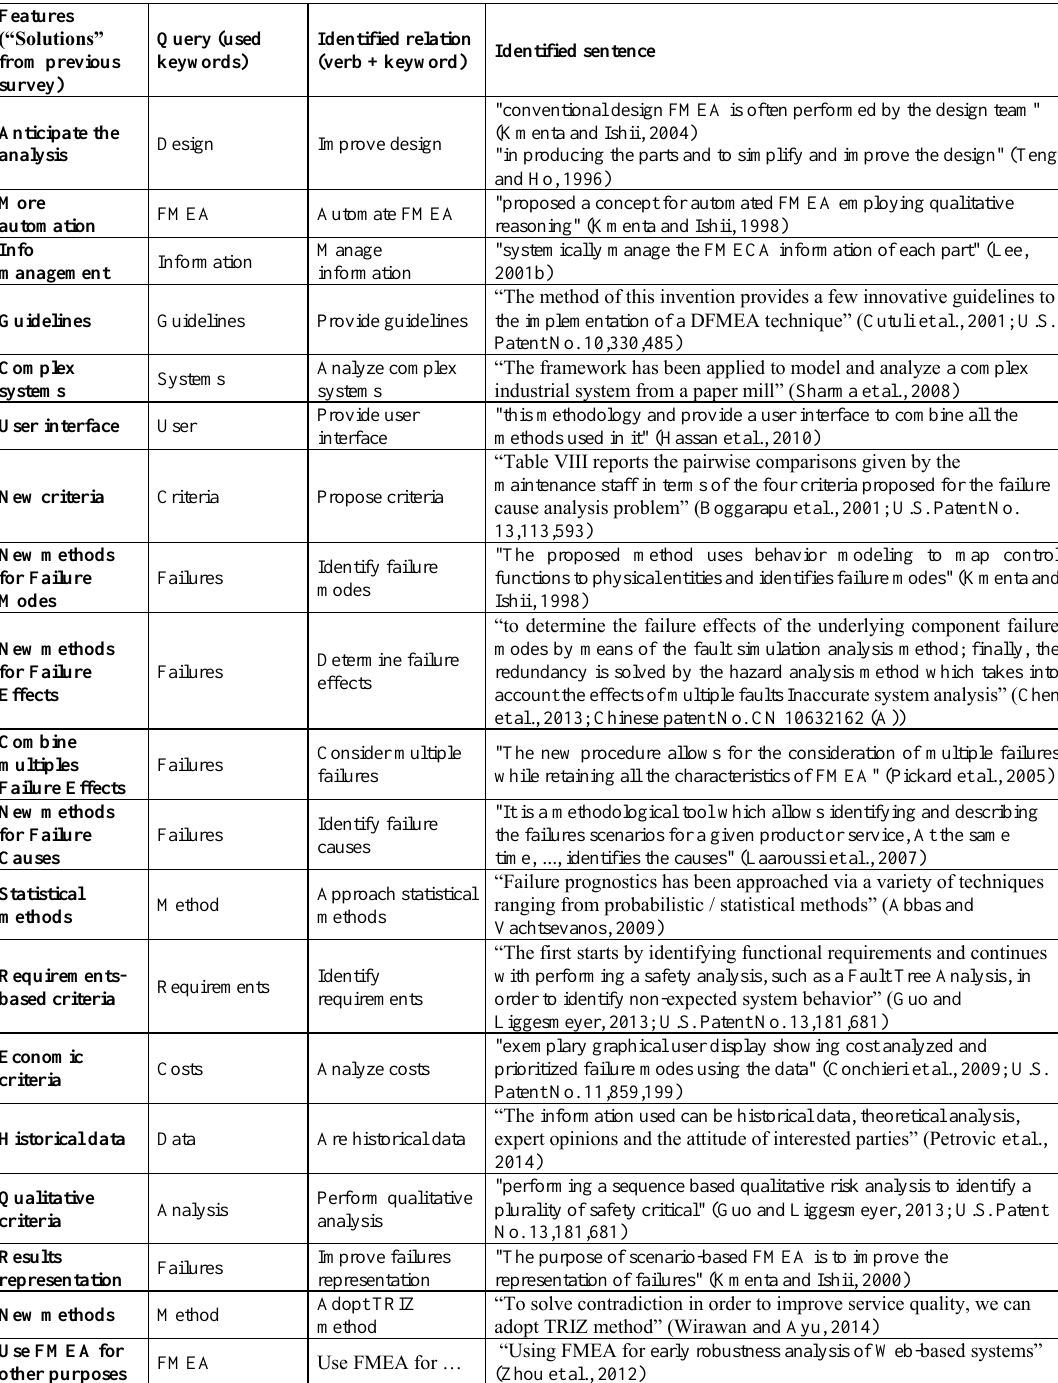
Table 5. Investigated solutions, used queries and obtained